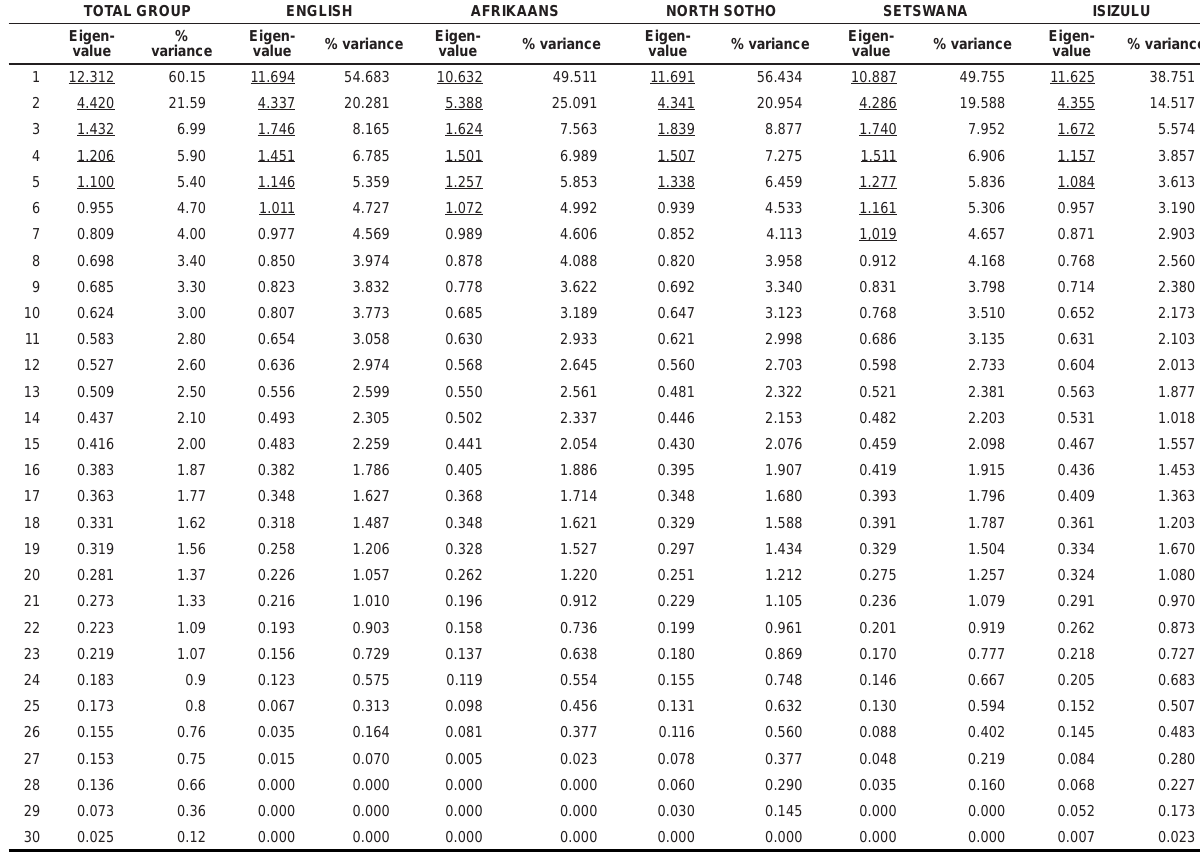
table 3 Eigen-values and percentage of variance explained (per group) for the unrotated factor